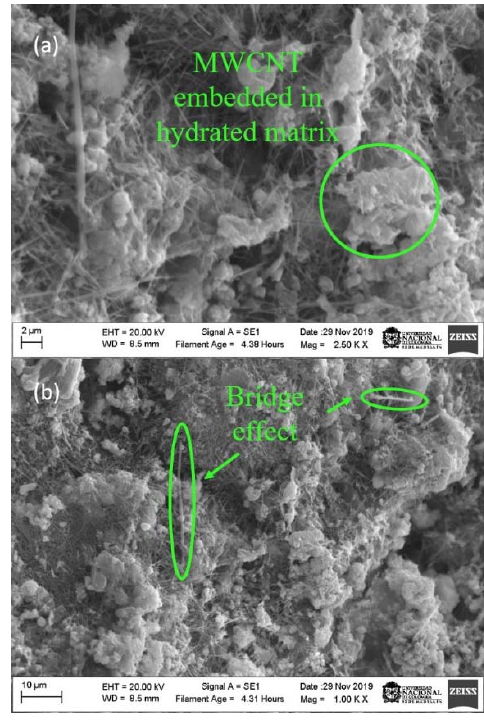
Figure 10. SEM images of Portland cement specimens with a dispersion solution addition at 490 J/g. ( a ) 2 μ m ( b ) 10 μ m.